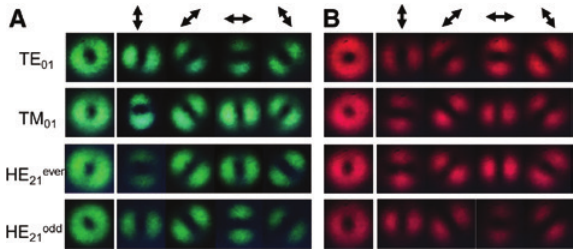
Figure 4: Polarization characteristic of cylindrical vector beams. Near-field intensity distribution of TM generated by all-fiber mode selective couplers at (A) 520 and (B) 638